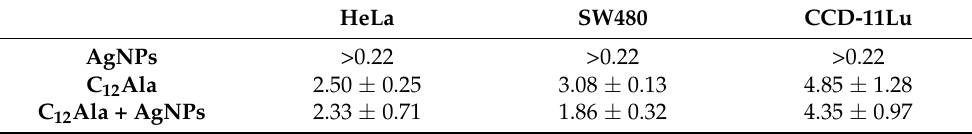
Table 2. IC 50 (mg/mL) against tumor and nontumor cells at 24 h of incubation. HeLa